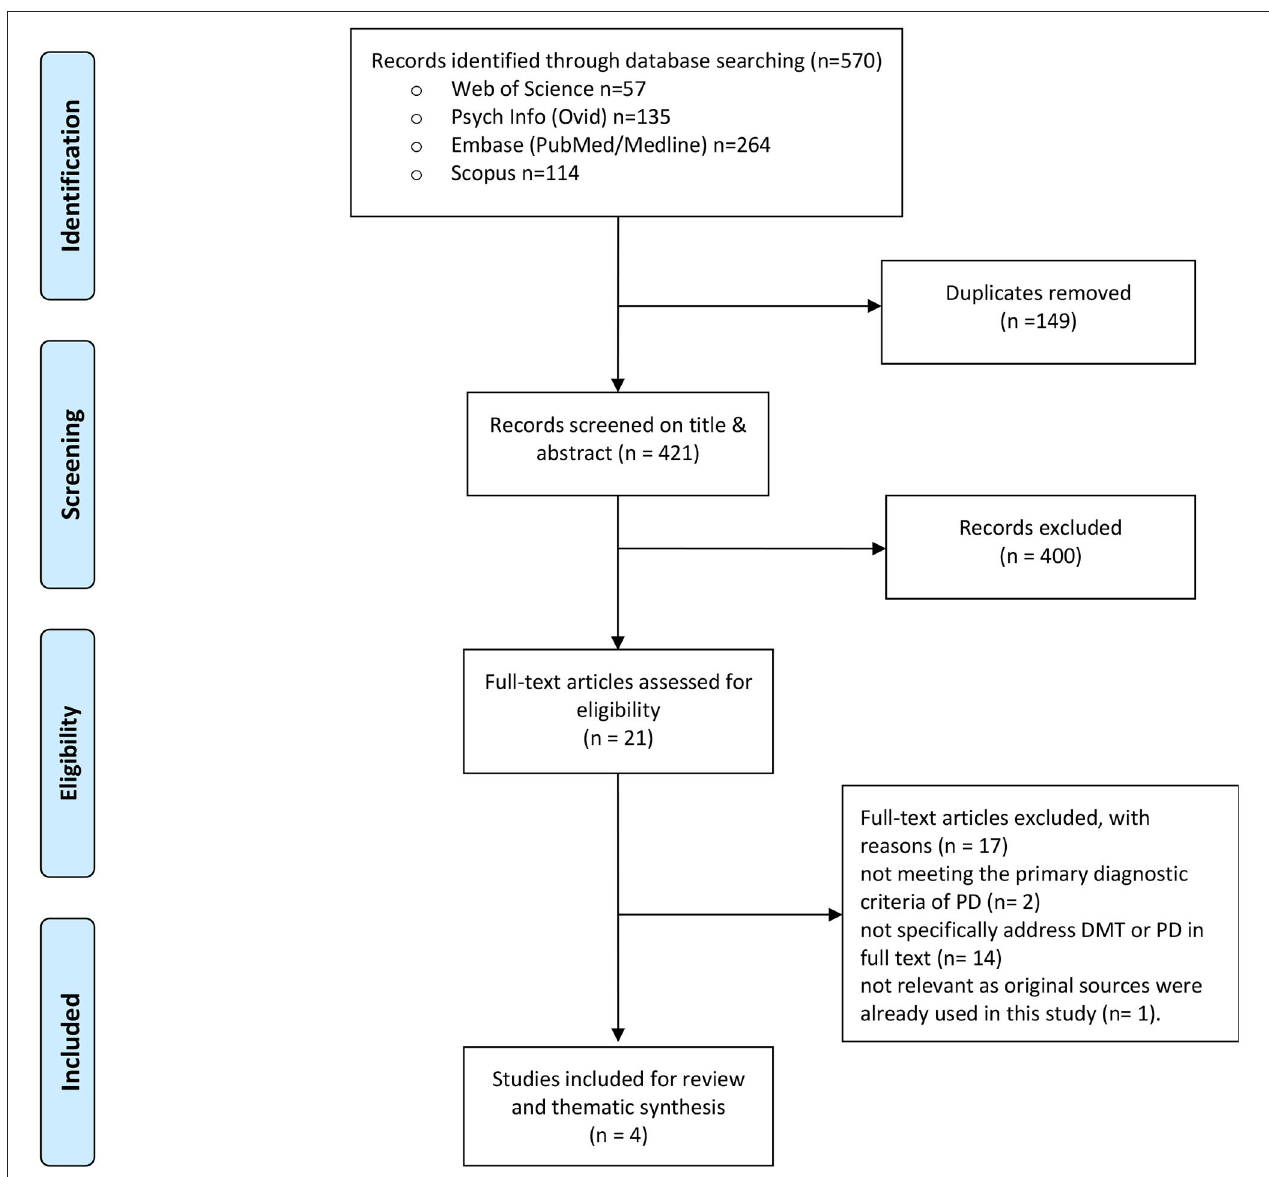
FIGURE 1 | PRISMA flow diagram: article selection. From Moher et al. (2009). For more information, visit www.prisma-statement.org.